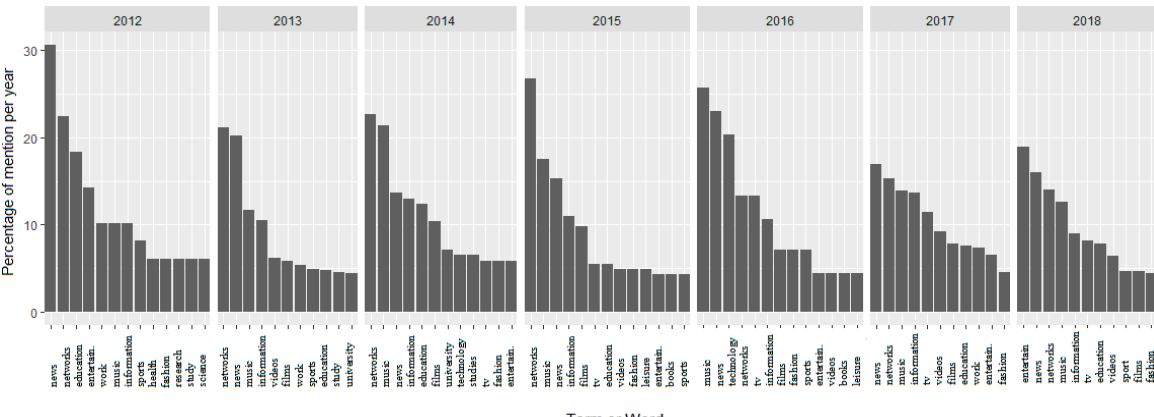
Figure 1. Frequency of mention of the word or related terms (per year) in response to the following question: What topics are you interested in seeing and consuming on the Internet?